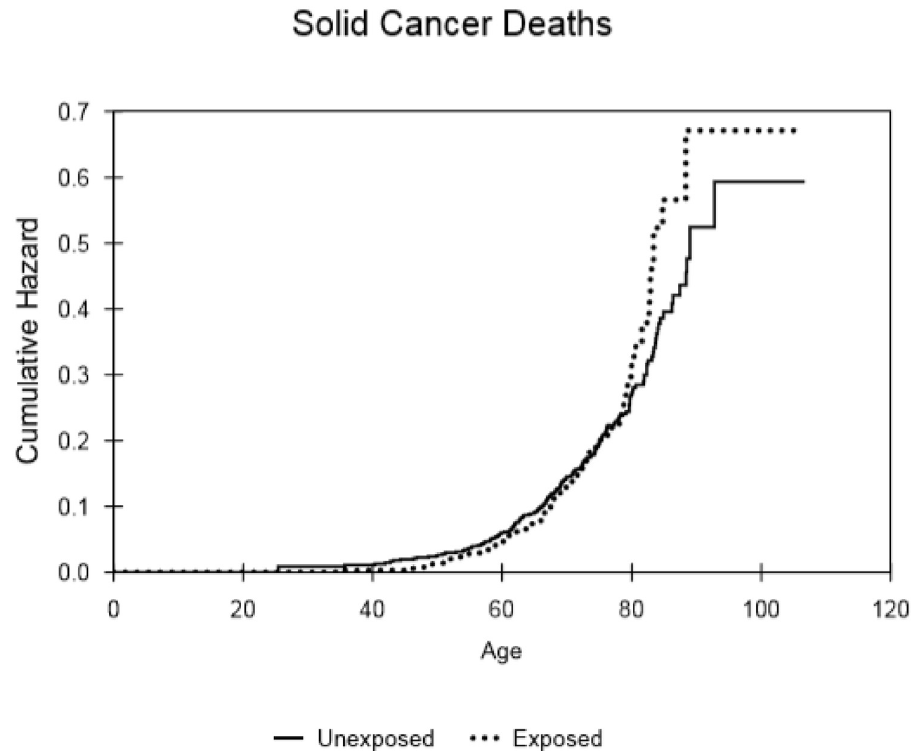
Fig 3. Cumulative hazard for all solid cancer, within the selected populations of males that either received the typical dose or did not receive 224 Ra treatment, as a function of attained age.